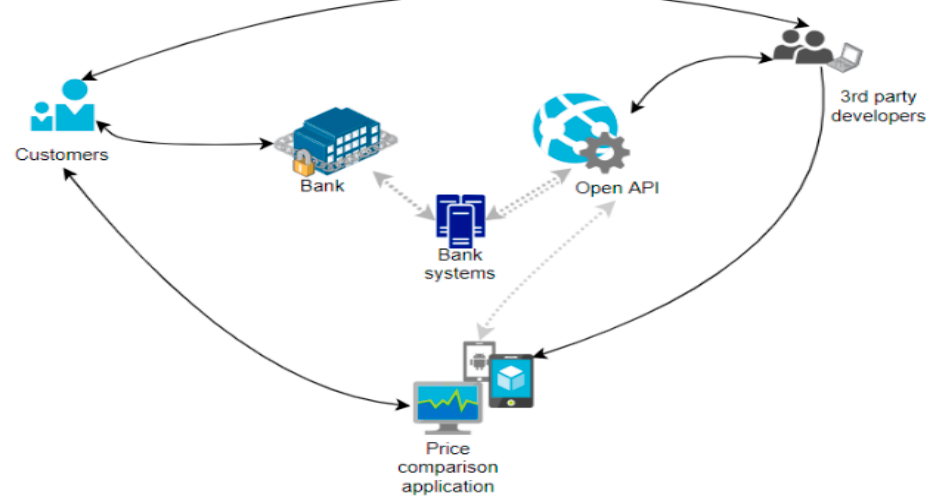
Figure 10. The structure of open banking (OB). Source: (Kand ı rmaz and Tiryaki 2018).